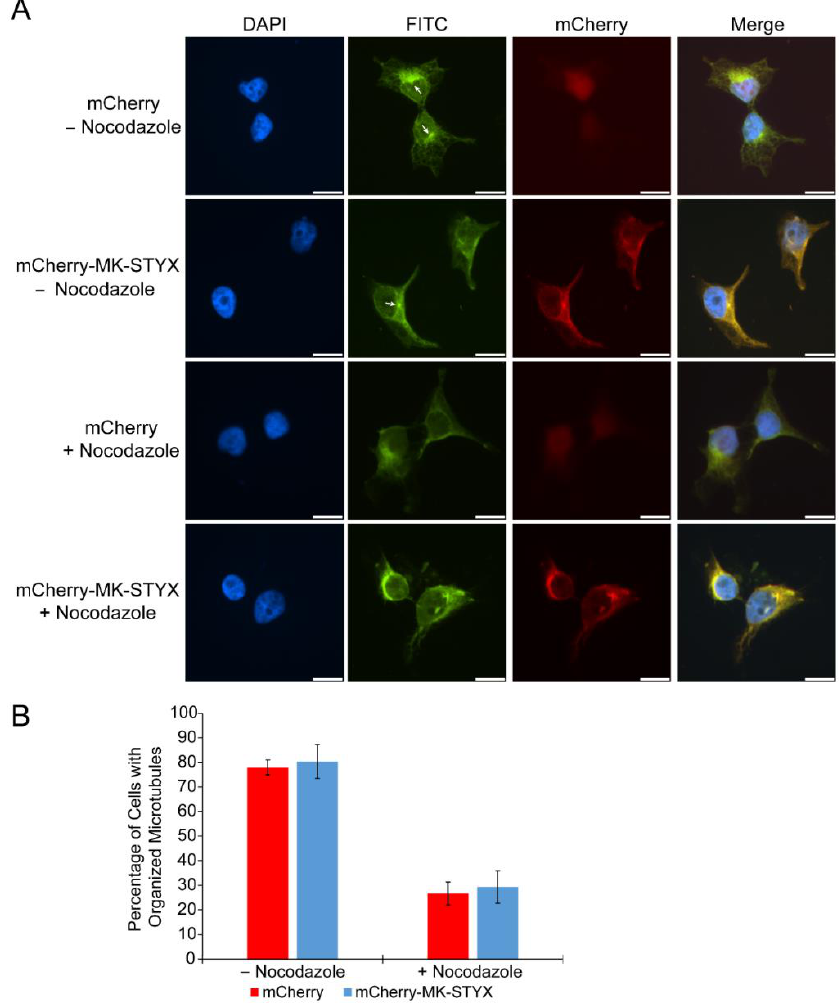
Figure 4. Microtubule organization is stable in the presence of MK-STYX. ( A ) Representative examples of microtubule organization, detected with an anti-tubulin antibody conjugated with FITC, in cells treated or not treated with nocodazole and in cells expressing mCherry or mCherry-MK-STYX, as indicated. ( B ) The number of cells with organized microtubules was scored in the presence or absence of nocodazole. In the absence of nocodazole, microtubules were well-organized in control cells (mCherry) and cells overexpressing MK-STYX, i.e., the microtubules nucleated from the centrosome (white arrow). However, microtubule organization was disrupted (tubulin was diffuse in the cytoplasm) in the presence of nocodazole in both control cells, as expected, and those expressing mCherry-MK-STYX. 100 cells were scored per replicate; three biologically independent replicates were performed. Scale bar, 10 µ m. The quantified data is the cumulative output of n = 3 independent biological experiments. Cell density was comparable for mCherry and mCherry-MK-STYX. Representative images were chosen to illustrate the subcellular distribution of tubulin.